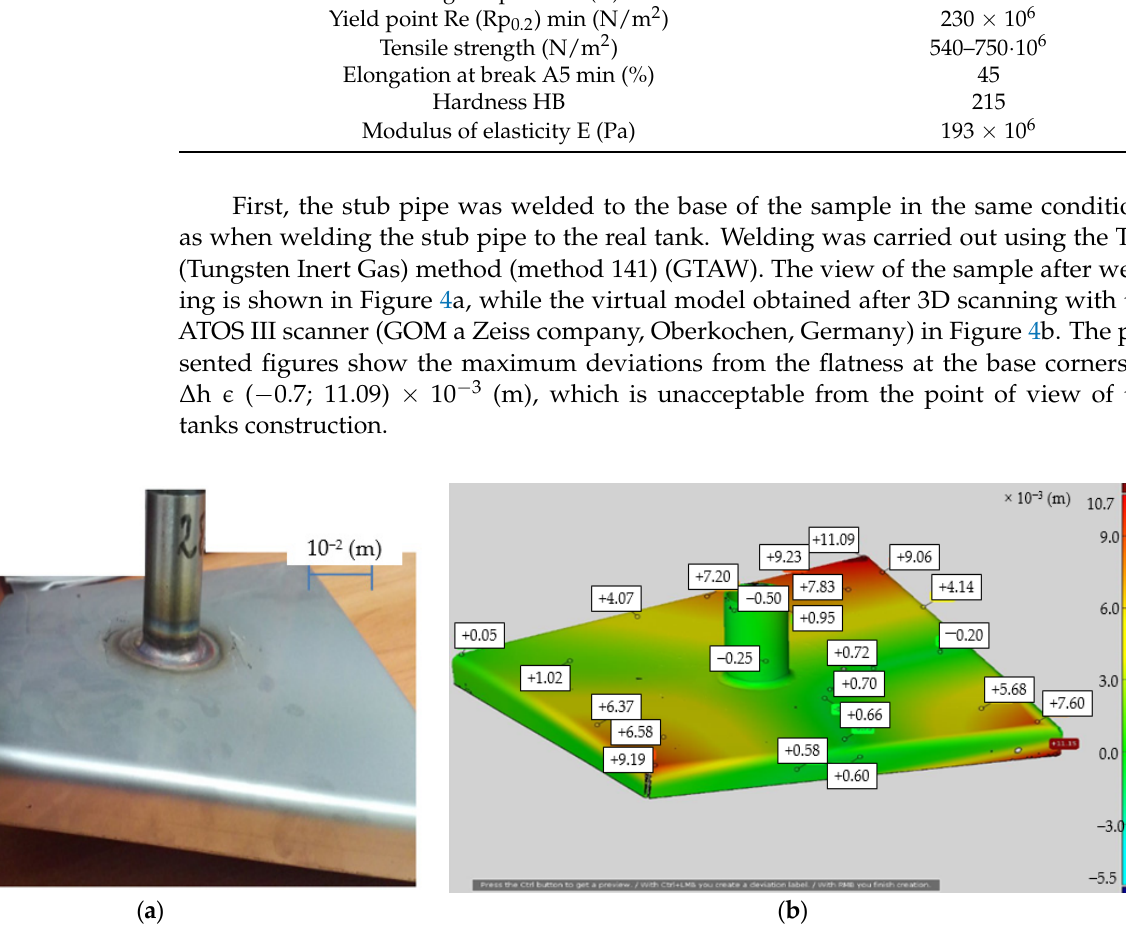
Figure 4. Test sample after TIG welding (method 141) (Gas Tungsten Arc Welding (GTAW)): photo of the real object ( a ), virtual model after 3D scanning with ATOS III scanner with measured deviation from the flatness values ( b ).